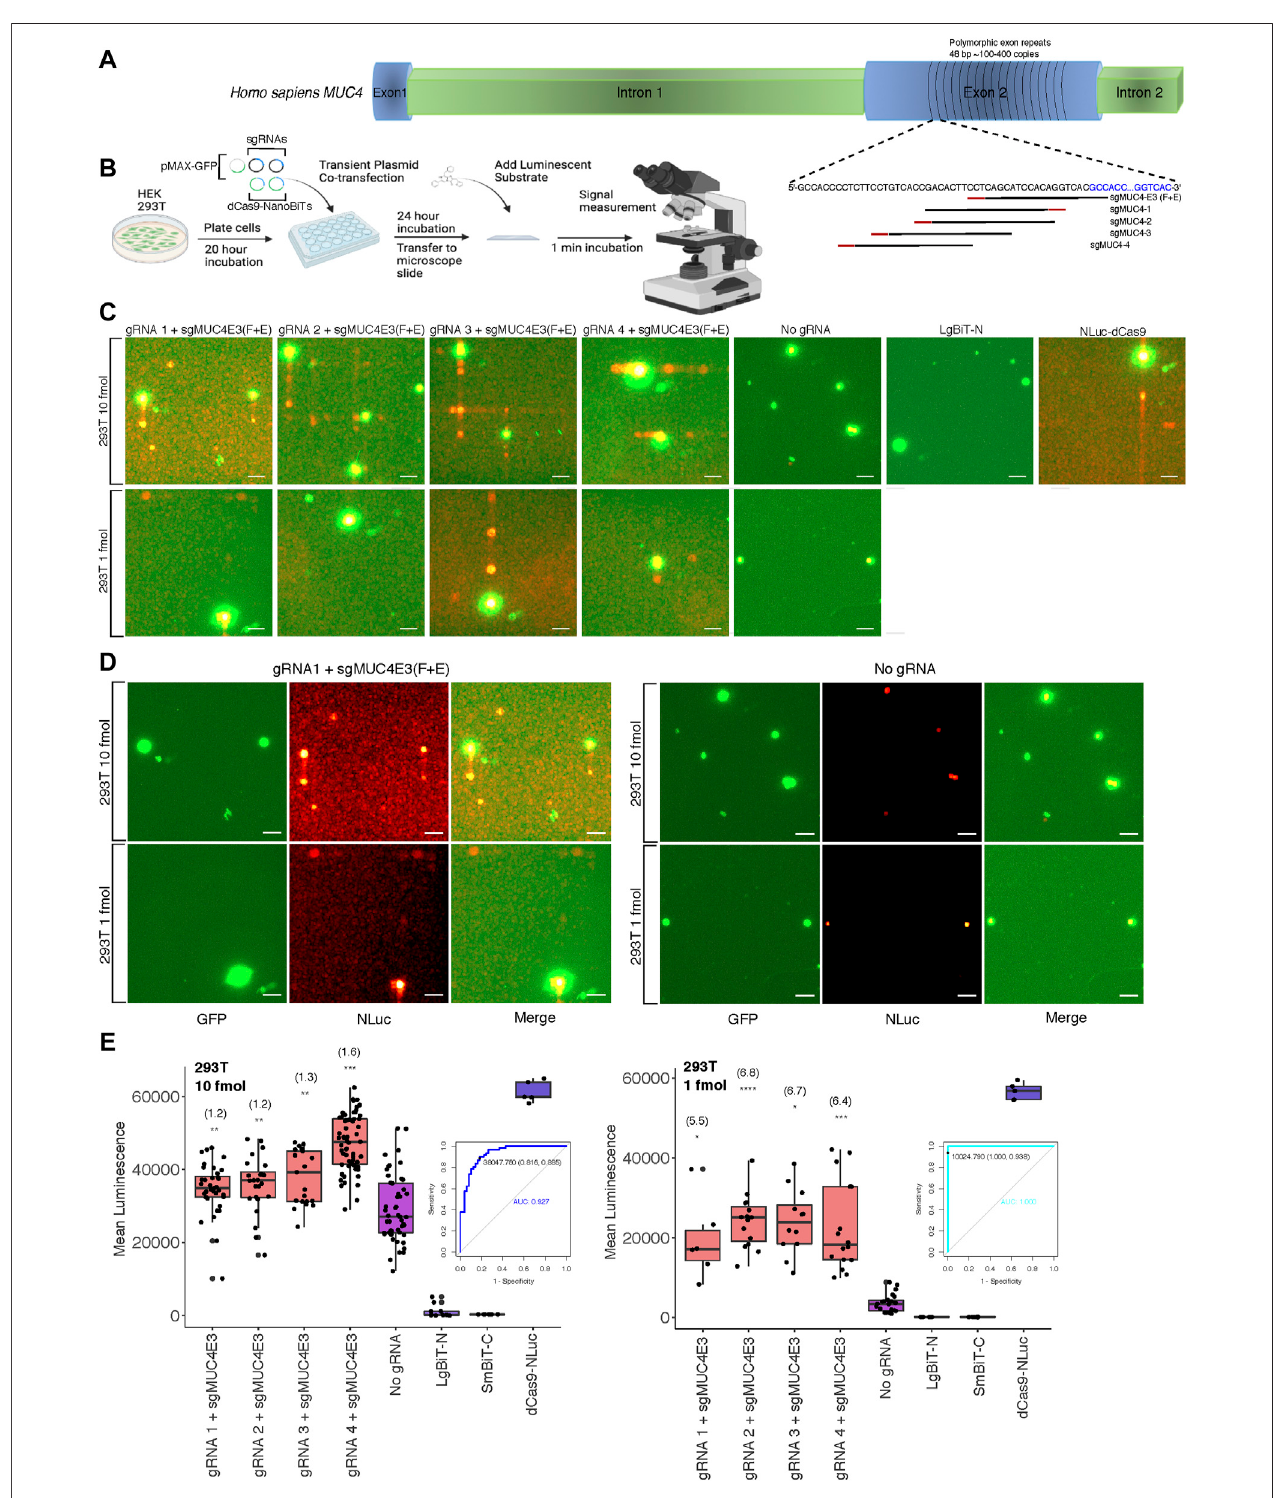
FIGURE2| Biosensingrepetitivegenomicsequencesatthehuman MUC4 locus (A) Cartoonvisualizationoftherepetitiveregionofexon2withinthehuman MUC4 locus showing sgRNA design strategy using the binding site for sgMUC4-E3(F + E) as an anchor point. (B) Depiction of experimental process for all live cell DNA biosensing assaysconductedusing microscopy,labeling allco-transfected plasmids. (C) Merged GFP fl uorescence (green) and NLuc luminescence(red) images taken on the Leica DM6000B upright microscope at 10 × magni fi cation depicting dCas9-NanoBiT biosensing of the repetitive region of MUC4 exon 2 in live HEK